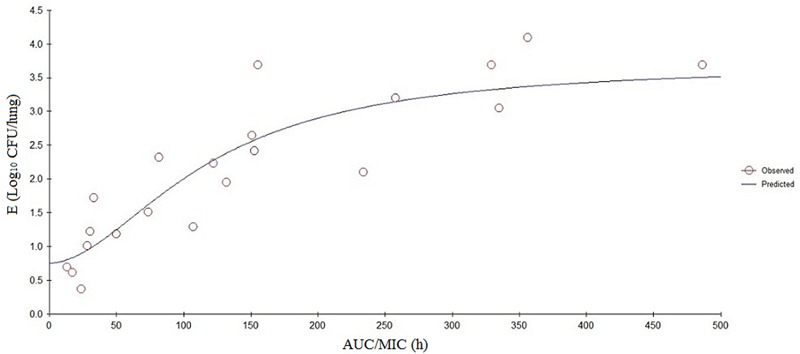
Sigmoid Emax relationships between antimycoplasmal effect (E, log10 CFU/lung) and in vivo AUC24/MIC ratio against M. gallisepticum in the lung tissues of chickens.